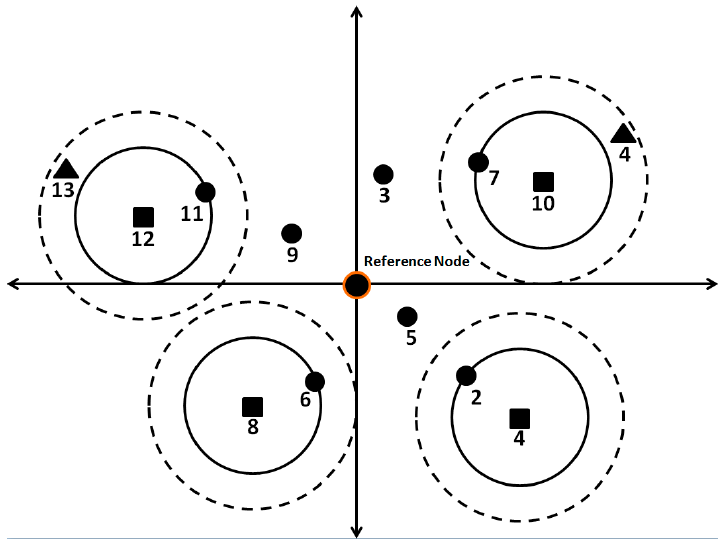
Figure 9. Partition handling.